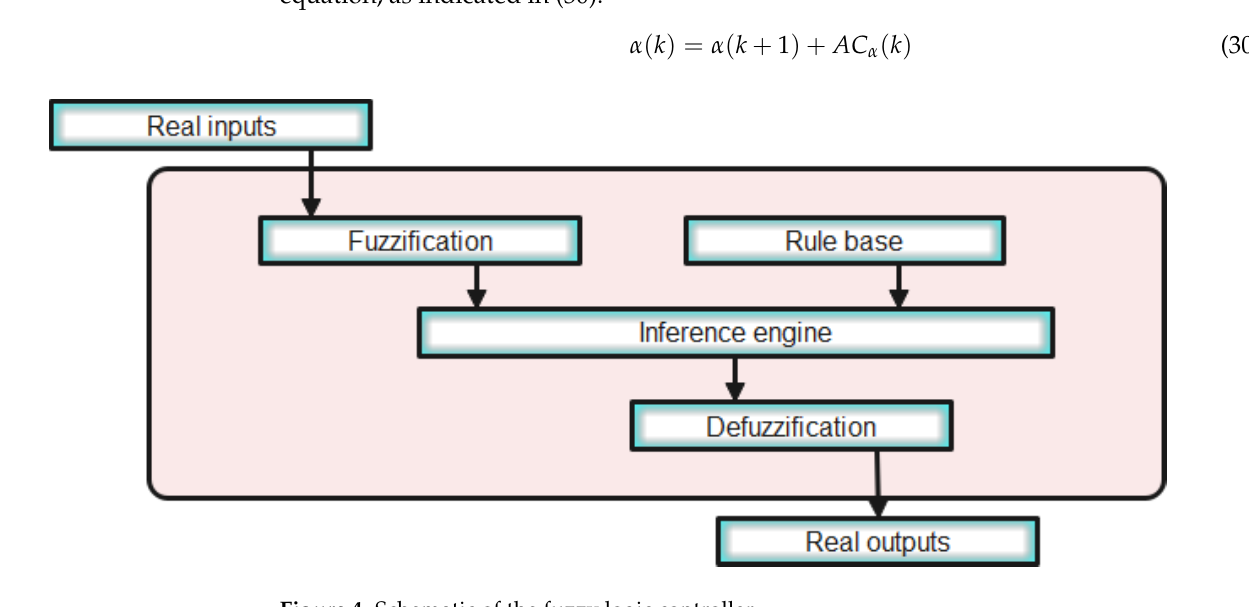
Figure 4. Schematic of the fuzzy logic controller.